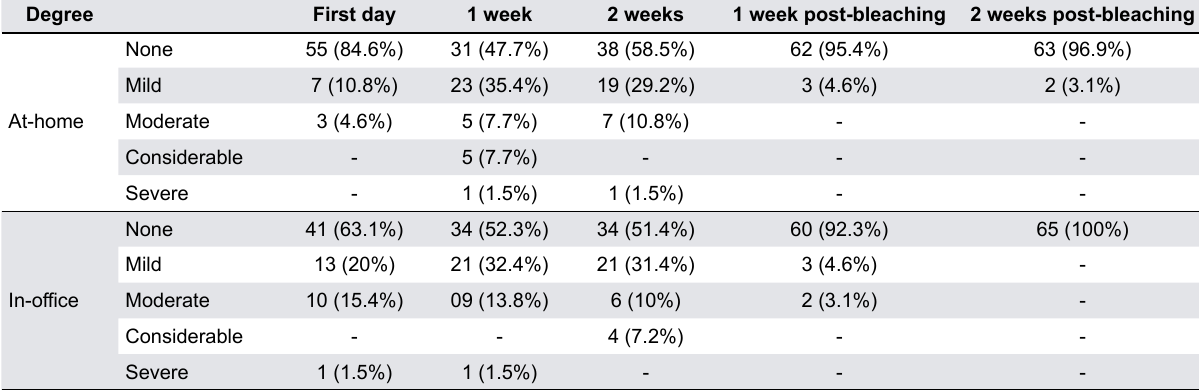
Table 5- Degrees of tooth sensitivity reported by volunteers in different treatment groups